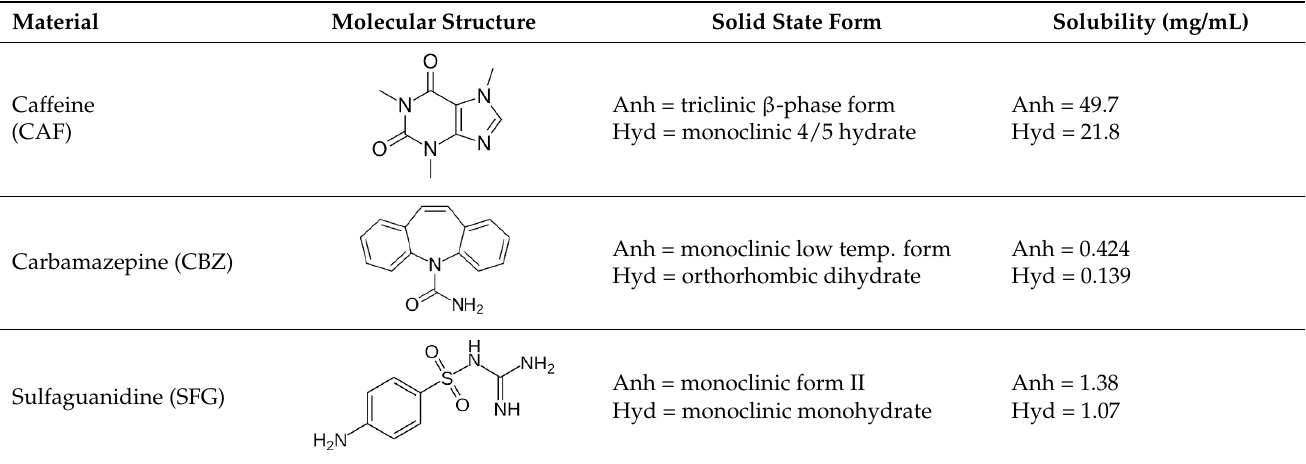
Table 4. Comparison of solubility data for three examples of hydrated and anhydrous compounds. Data reprinted with permission from Ref. [59]. 2008, Elsevier.